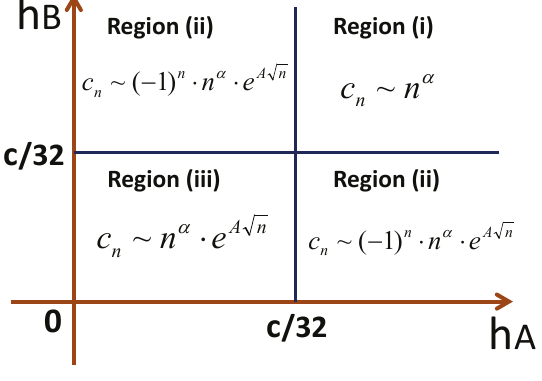
Figure 5 . The sketch of behaviors of c n for various values of ( h A , h B